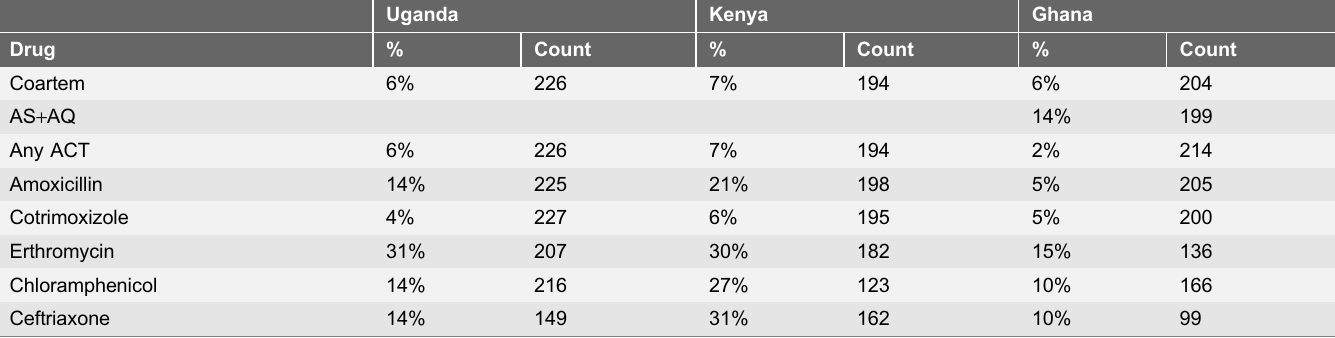
Table 3. Stock-out of essential medicines to treat malaria, pneumonia and meningitis by